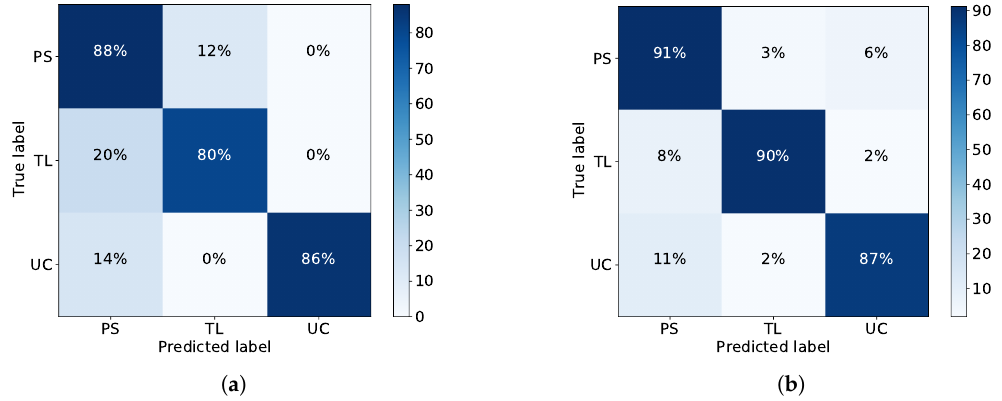
Figure 5. The confusion matrices (in percentage) for the best random forest classier and the CVAE model for junction arm rule prediction. ( a ) Confusion matrix for the random forest classier with oversampling and AdaBoost. ( b ) Confusion matrix for the CVAE model for junction arm rule